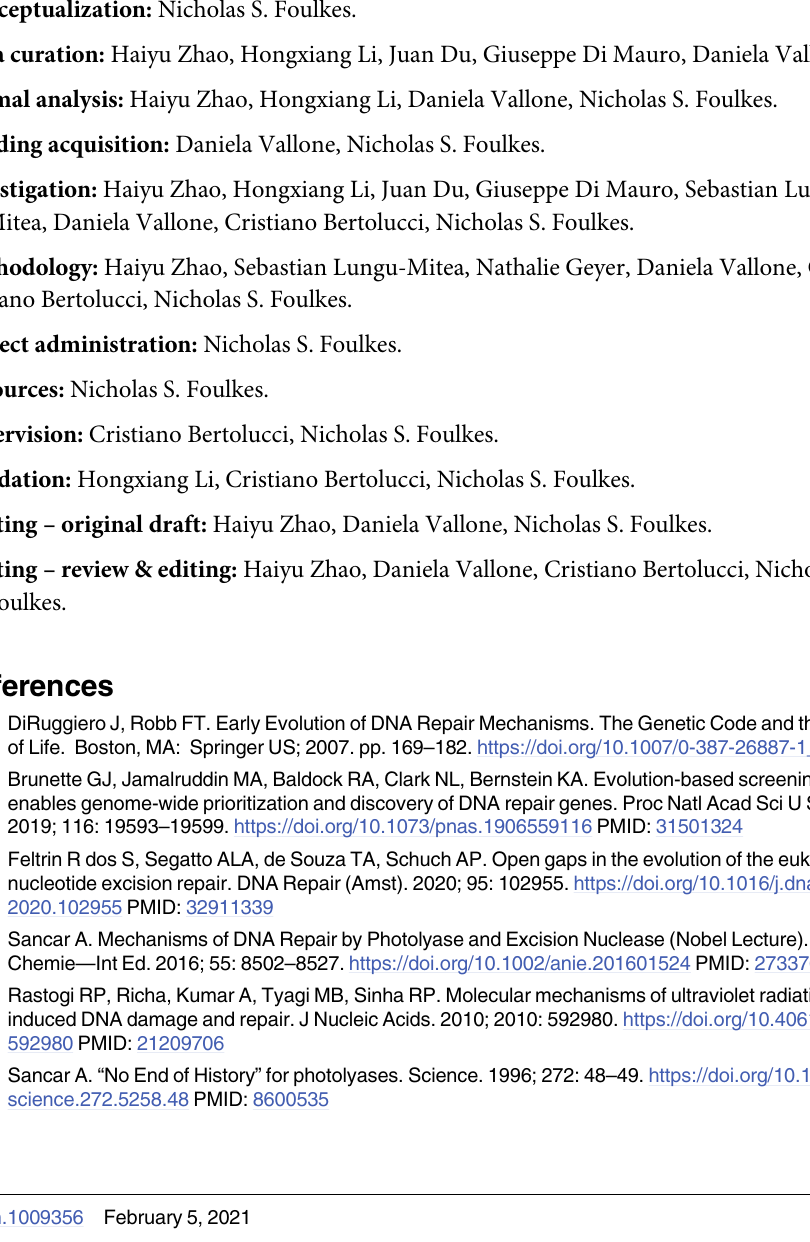
S3 Table. ddb2 promoter reporter constructs. S4 Table. Primer sequences for qRT-PCR analysis. S1 Dataset. Data used to make all the figures and statistical